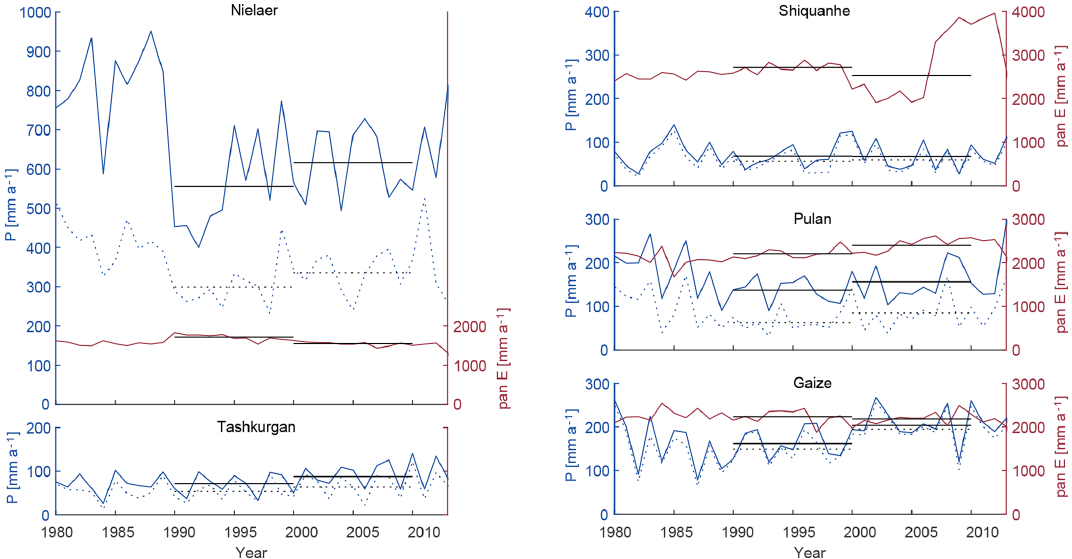
Figure 6. Annual precipitation ( P , blue line), pan evaporation (pan E , red line) and summer precipitation (dotted lines) for five stations on the southern and western TP (Fig.